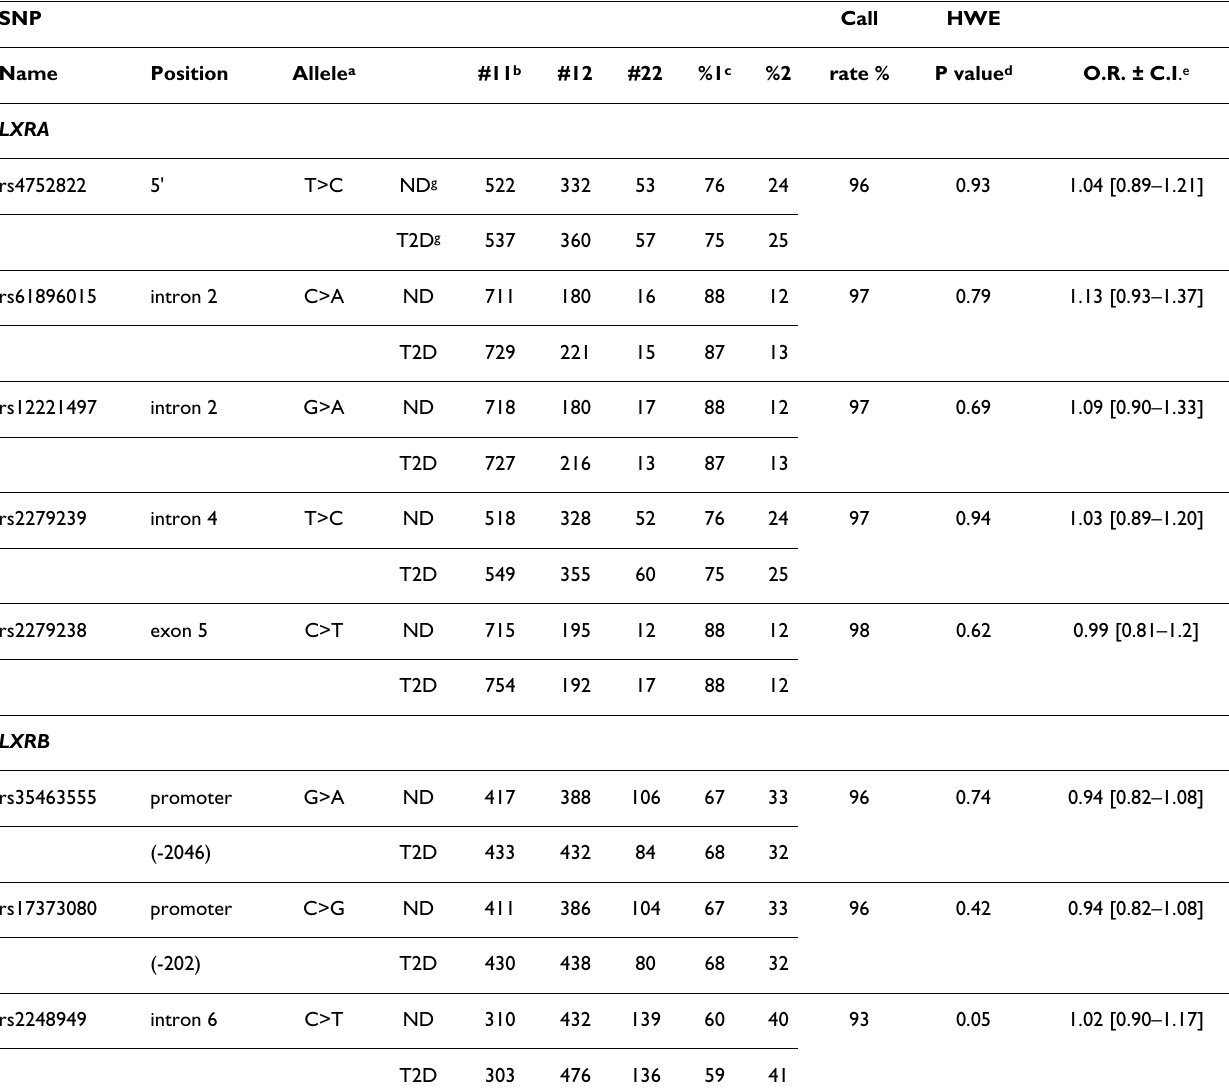
Table 1: Analysis of association between LXR alleles and T2D in French cases vs control SNP Call